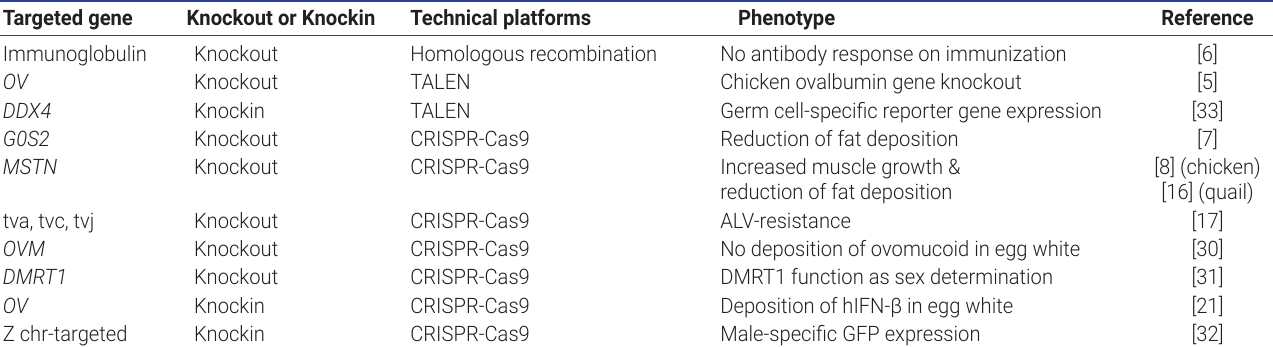
Table 1. Summary of the gene-edited chickens and quails Targeted